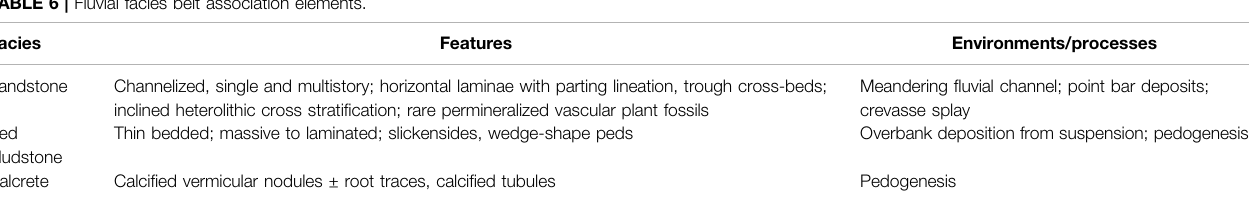
TABLE 6 | Fluvial facies belt association